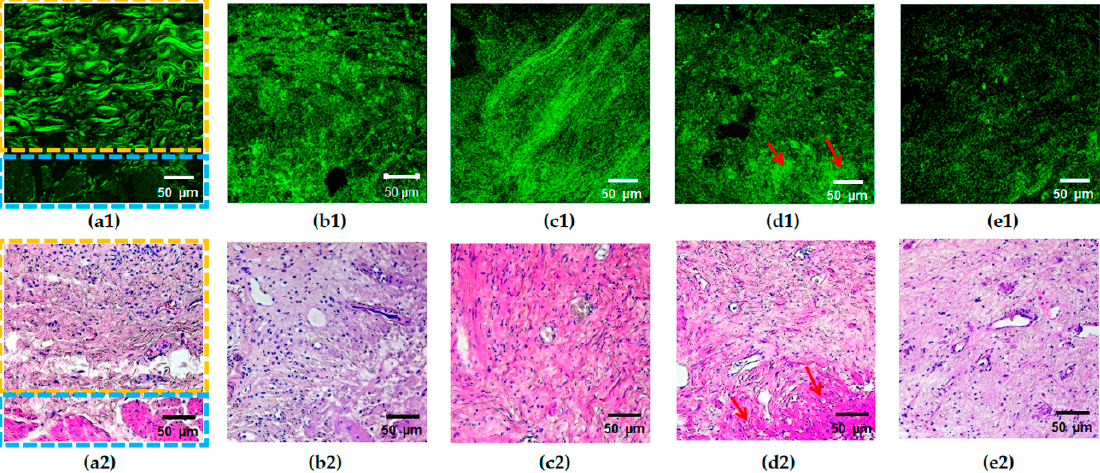
Figure 3. Typical SHG images ( a1 – e1 ) of the bladder mucosa with the corresponding histology ( a2 – e2 ) in the studied patients’ groups: ( a ) “normal” group, the border of the submucosal (marked with a yellow rectangle) and the muscular (marked with a blue rectangle) layers are clearly seen; ( b ) “chronic cystitis” group; ( c ) “Grade 2 radiation cystitis” group; ( d ) “Grade 3 radiation cystitis” group, hyalinosis structures are marked with red arrows; ( e ) “Grade 4 radiation cystitis” group.